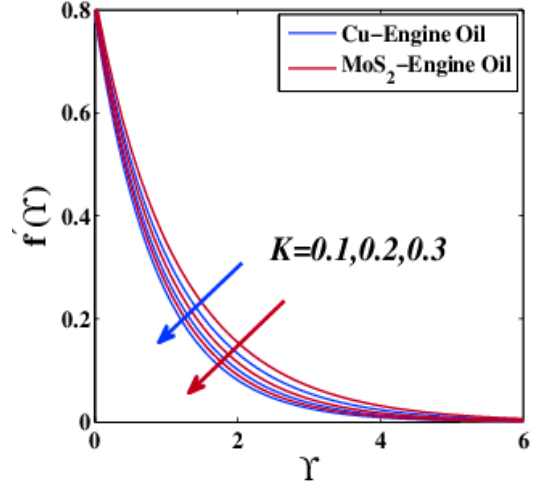
Figure 9. The effect of β 2 on entropy generation variation N G .